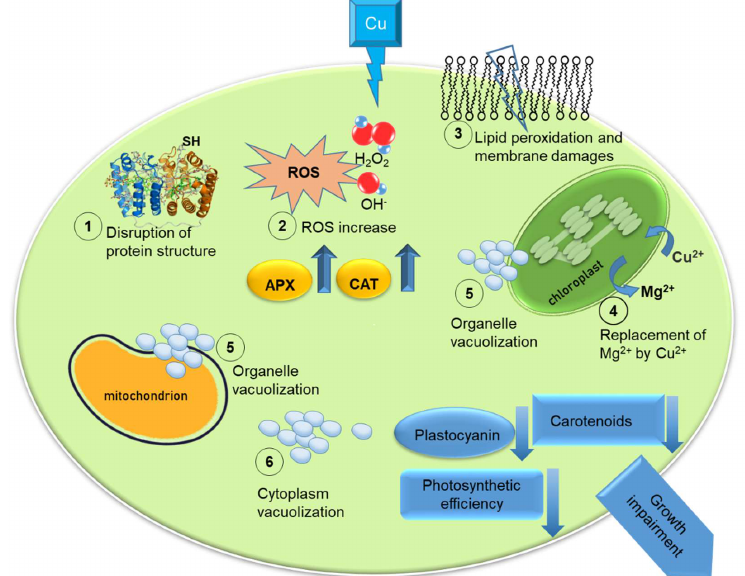
Figure 1. Illustration of the effects of high copper (Cu) concentrations on microalgal cells: disruption of protein structure (1), increase in reactive oxygen species (ROS) (2); lipid peroxidation and membrane damages (3); organelles vacuolization (4); replacement of Mg 2+ by Cu 2+ (5); cytoplasm vacuolization (6). Upward arrows indicate an increase in ascorbate peroxidase (APX) and catalase (CAT) in the cell; downward arrows indicate a decrease in availability of carotenoids and plastocyanin, and impairment of photosynthetic efficiency. The outcome of these effect is the impairment of growth rate.